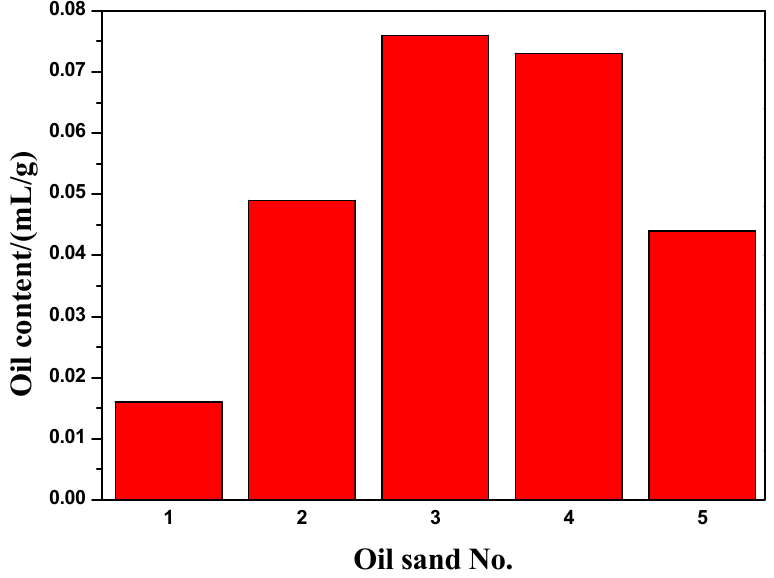
Figure 10. Oil content of oil sand in different parts of heterogeneous plate model.